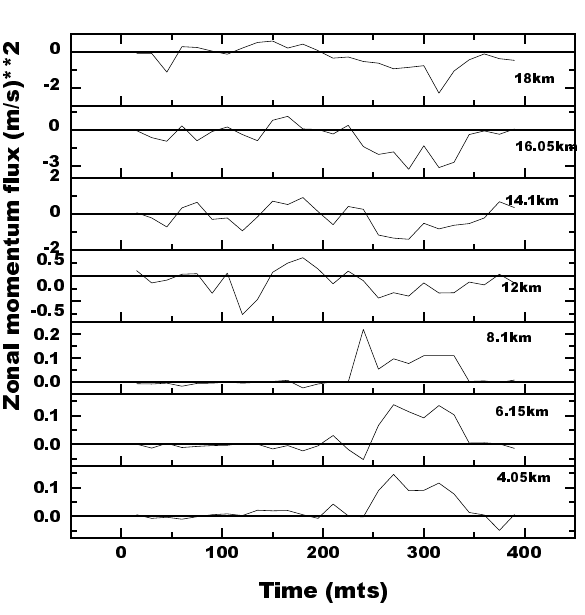
Fig. 12. Time evolution of zonal momentum flux on 28 August 1999 during 09:00 to